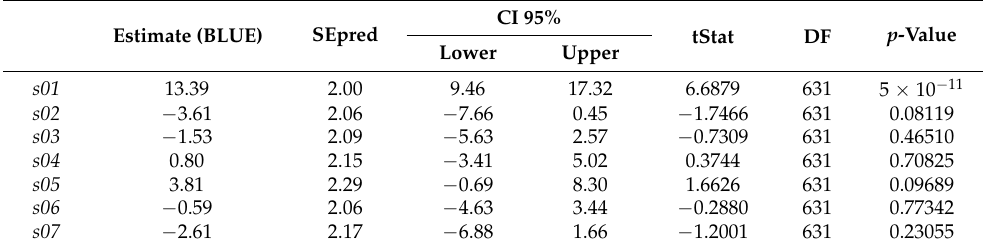
Table 1. Estimates of fixed effects ( isFeedbacked:subj ) best linear unbiased estimators and related statistics for all well-known imagery conditions (FL, FR, SL and